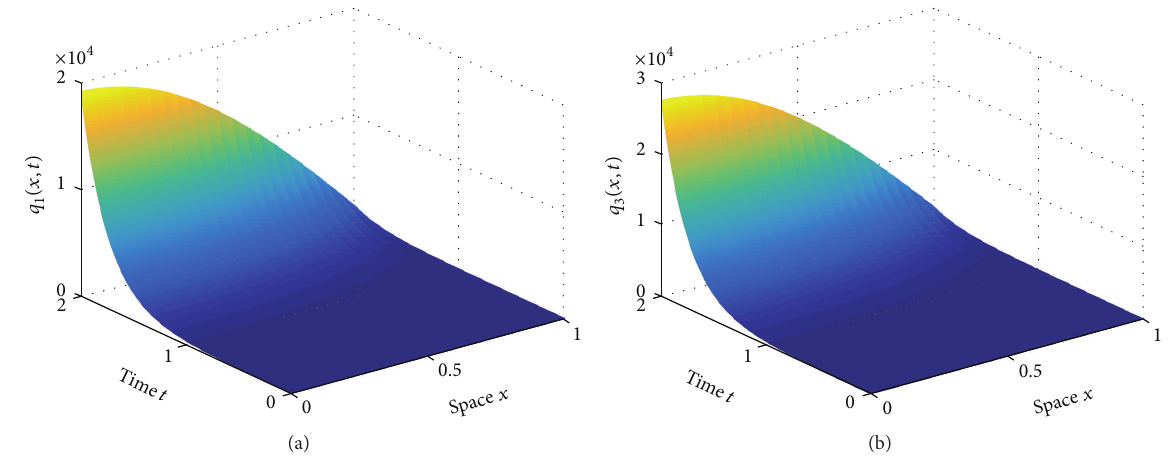
Figure 1: Spatiotemporal evolution of 𝑞 1 (𝑥,𝑡) (a) and 𝑞 3 (𝑥,𝑡) (b).